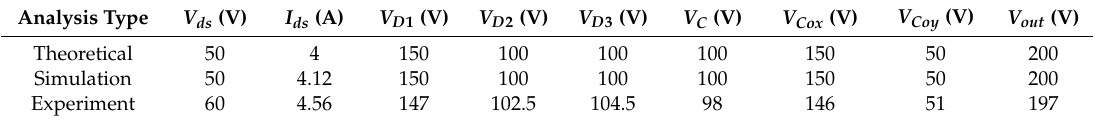
Table 5. Comparison details of the simulation and experimental results.